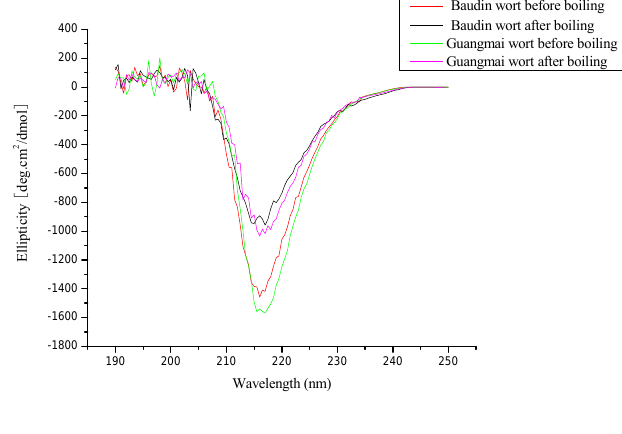
Figure 8 . The CD spectra for wort protein before and after boiling between the two